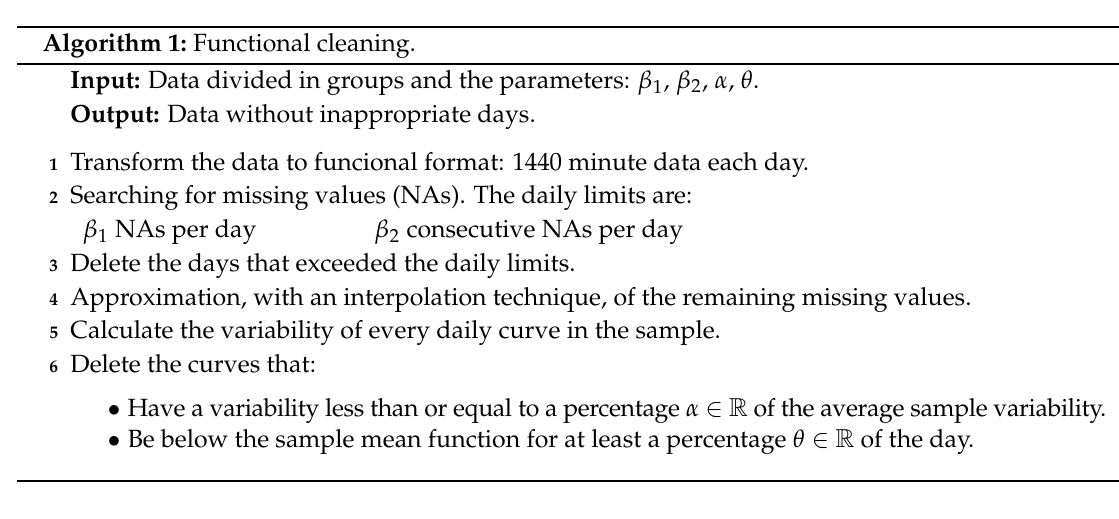
Figure 4. Performance of the Functional cleaning algorithm with an example variable: Electrical demand on the second floor of the building in the representative months (in dark gray the data before the refurbishment, in light gray after). The number of days taken into account in each sample is also shown: ( left ) the raw data and the mean functions separated between before and after the refurbishment; and ( right ) the data after applying the algorithm and the mean functions separated between before and after the